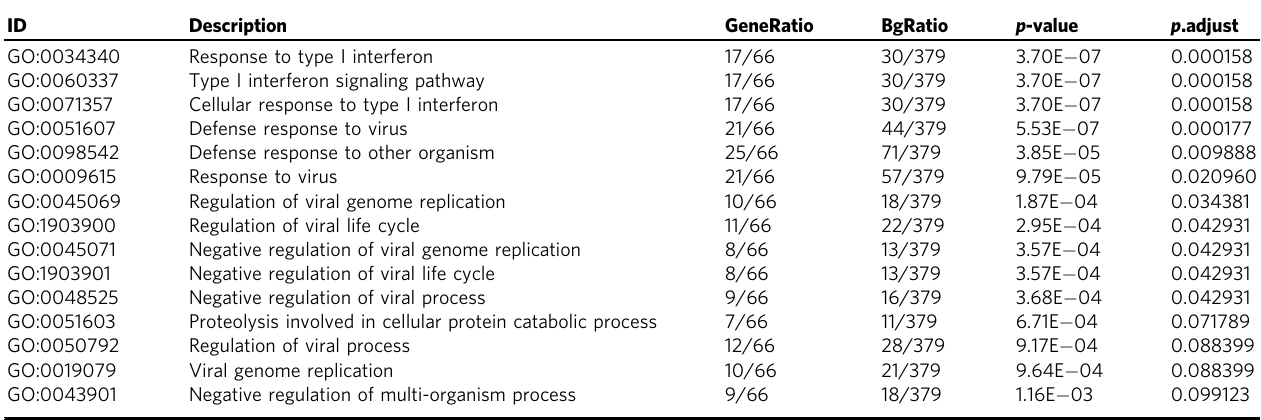
Table 2 Gene ontology enrichment analysis of genes upregulated in COVID-19